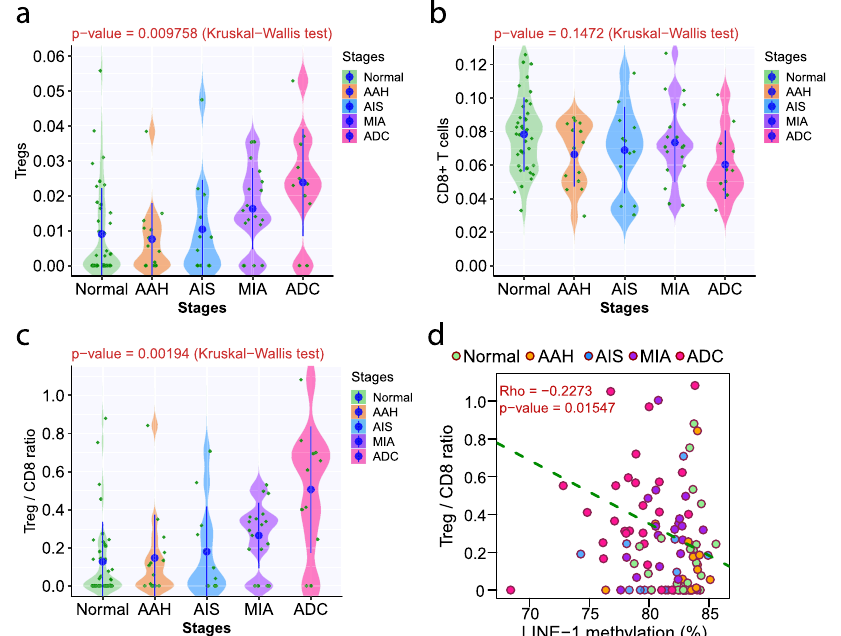
Fig. 7 T cell in fi ltration in IPNs of different stages. The immune cell fraction of T regulatory cells (Tregs) ( a ), CD8 + T cells ( b ), and Treg/CD8 ratio ( c ) in IPNs of different stages. Each green dot represents the mean immune cell fraction in each IPN and the blue dots represent the means of immune cell fraction in IPNs of each histologic stage with 95% con fi dence intervals as error bars. The differences among all stages were assessed using the Kruskal – Wallis H test. d Correlation between LINE-1 methylation and Treg/CD8 ratio was assessed by Spearman ’ s correlation analysis. Each dot represents each specimen. Source data is provided as a source data fi